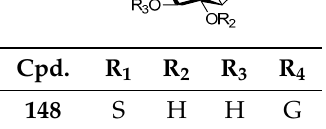
Figure 12. Structures of compounds 145 – 147 .